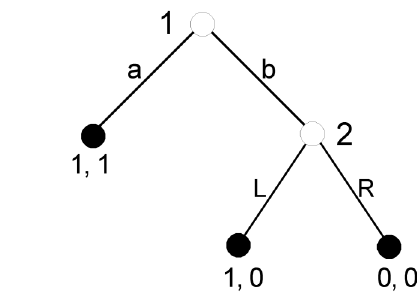
Figure 6. A game with BI solution that includes a weakly dominated strategy